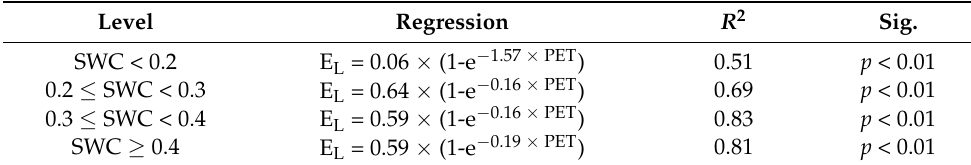
Table 4. The response of Ec to PET under varying SWC.